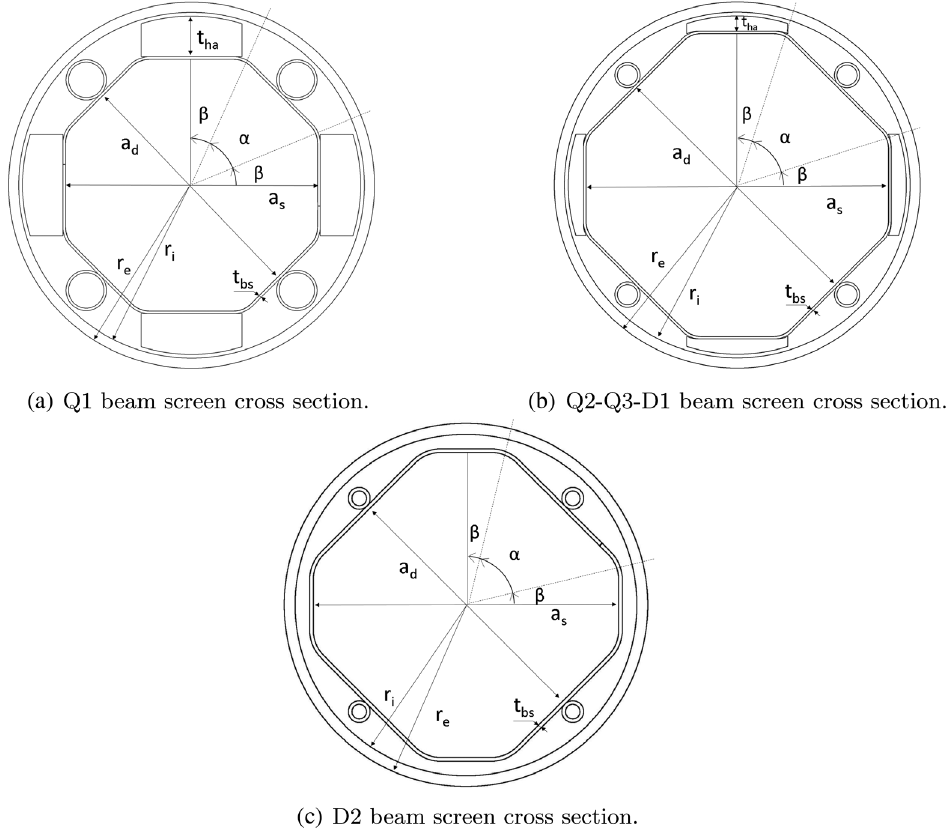
FIG. 4. Different types of beam screens for the IR